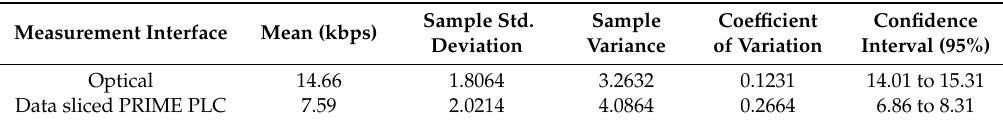
Table 6. Statistical analysis of throughput test